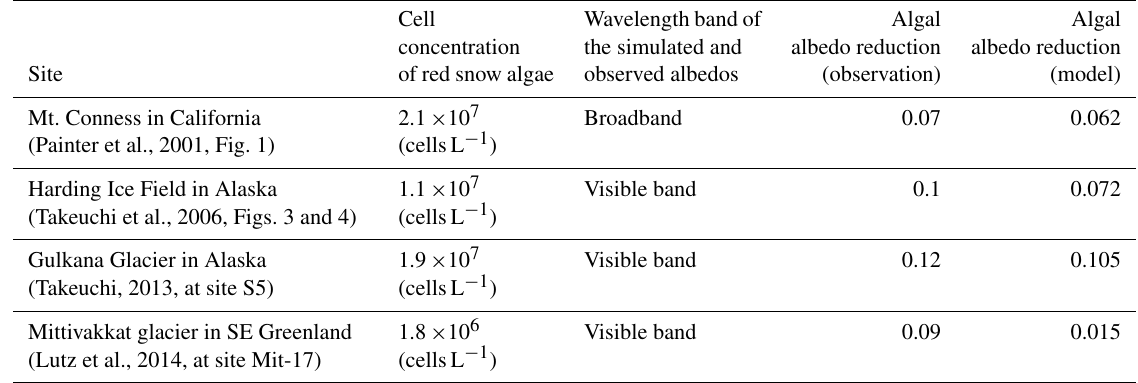
Table 2. The information for model validation with field observations. The wavelength band of the simulated snow albedo was adjusted to that of the observed snow albedo.